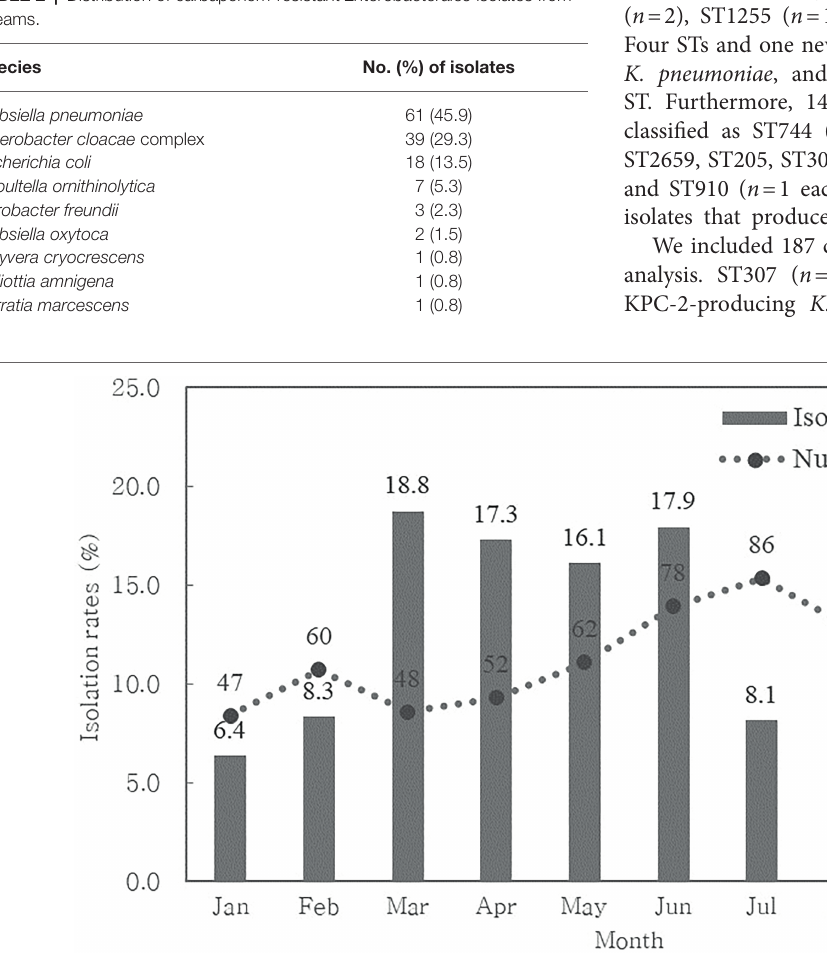
FIGURE 1 | Monthly carbapenem-resistant Enterobacterales isolation rates for stream